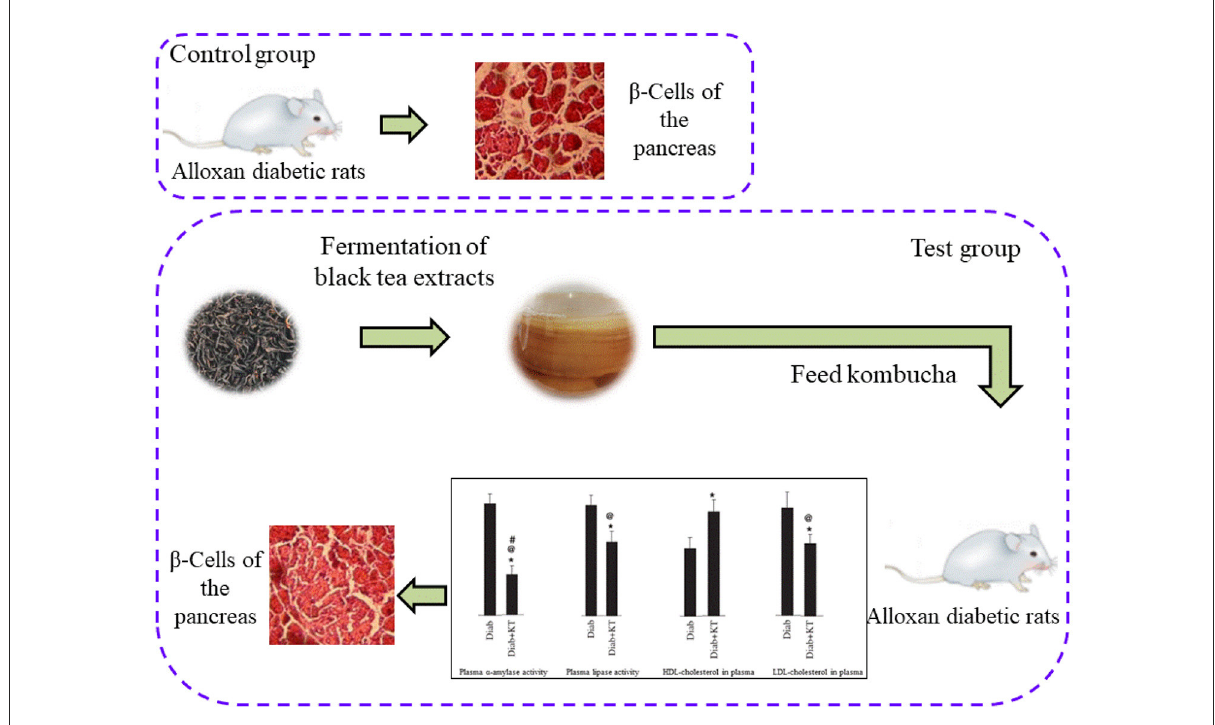
FIGURE4 Effect of fermented black tea extract on β -cells of the Pancreas in Alloxan diabetic